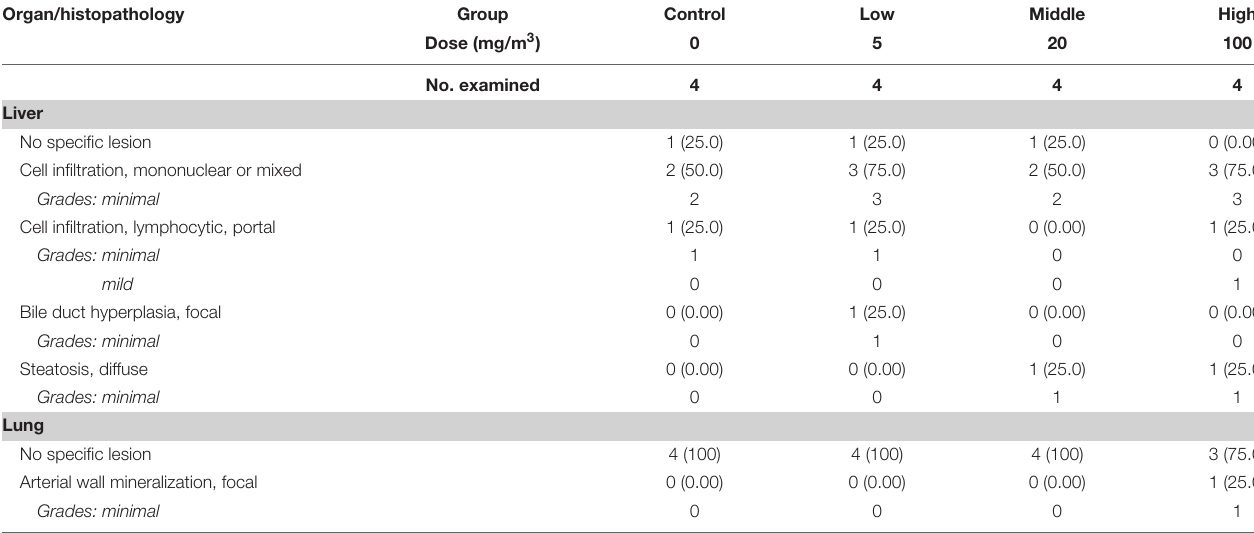
TABLE 1 | The summary of the histopathological results of rats repeatedly inhaled with sodium metabisulfite (SM).